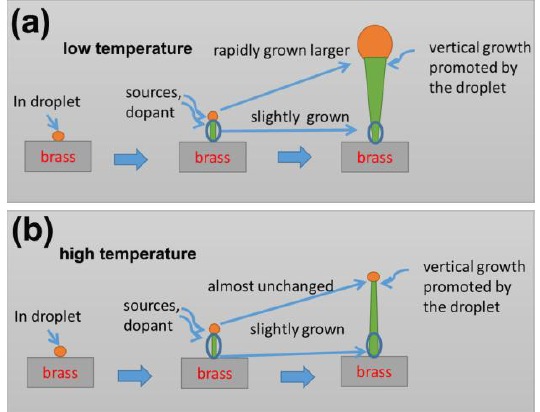
Figure 9. Schematic illustrations of the growth mechanisms of the InN nanowires grown at ( a ) low and ( b ) high temperatures.